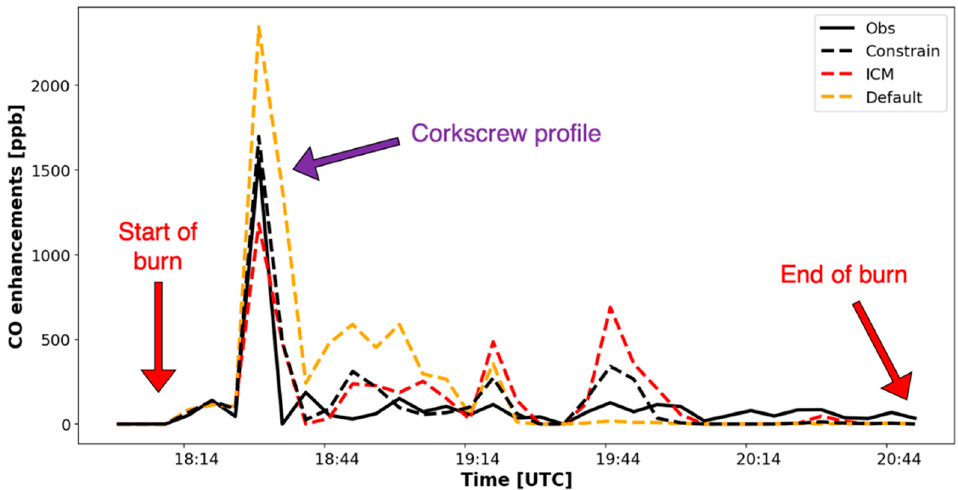
Figure 6. Modeled vs. observed CO enhancements during the L2F prescribed burn. Modeled and observed enhancements were averaged every 5 min.